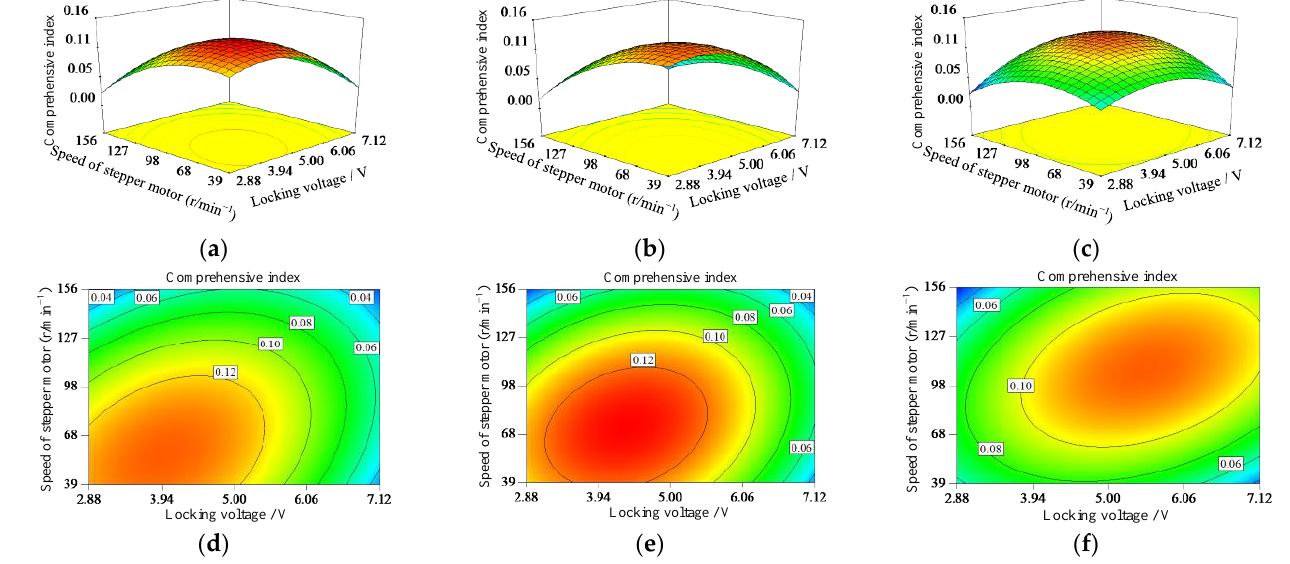
Figure 8. Influence of locking voltage and speed of stepper motor on comprehensive evaluation index: ( a ) Response surface of 15 ◦ MMS; ( b ) Response surface of 30 ◦ MMS; ( c ) Response surface of 45 ◦ MMS; ( d ) Contour plot of 15 ◦ MMS; ( e ) Contour plot of 30 ◦ MMS; ( f ) Contour plot of 45 ◦ MMS.